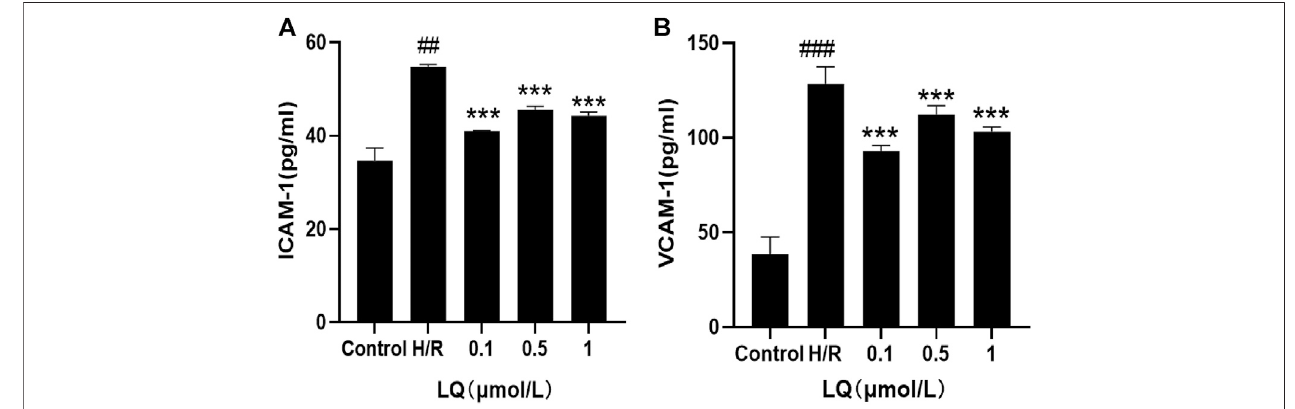
FIGURE 4 | LQ decrease the increase of ICAM-1 and VCAM-1. (A) Compared with control, the expression of ICAM-1 was increased in H/R group, and LQ could reducetheelevatedICAM-1. (B) Comparedwithcontrol,theexpressionofVCAM-1wasincreasedinH/Rgroup,andLQcouldreducetheelevatedVCAM-1. ## p < 0.01,